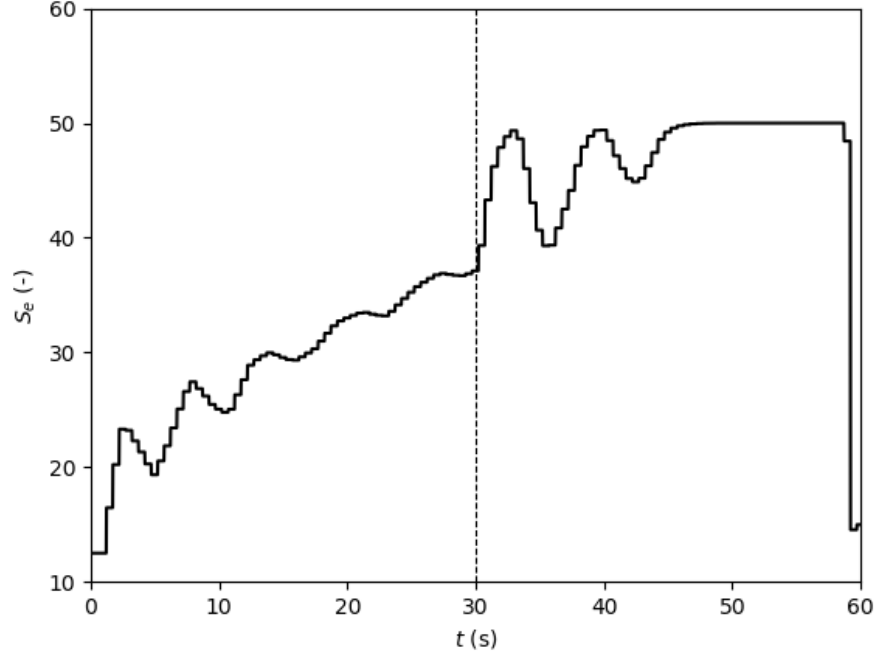
Figure 27. Effective swirl number profile, feedback with downgraded regulation law, case